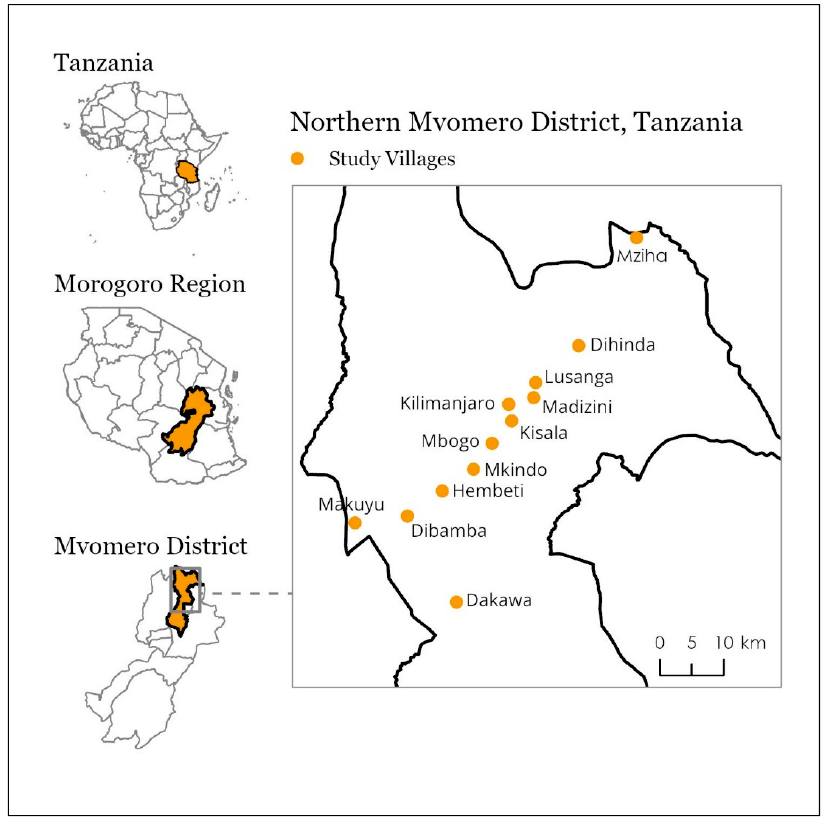
Figure 1. Location of 12 villages included in the larviciding intervention in the Mvomero District of Tanzania. Locations are